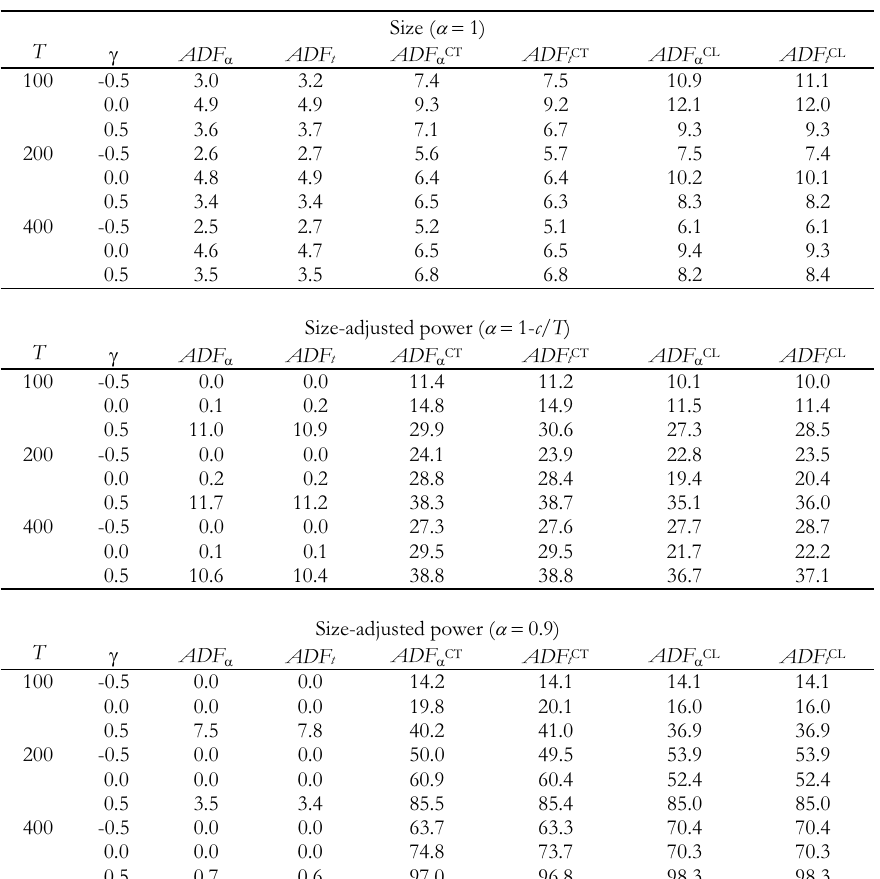
Comparison between standard Dickey-Fuller tests and the new unit root tests based on traditional level shift estimation. Model S (four level shifts at fixed fractions of the 4